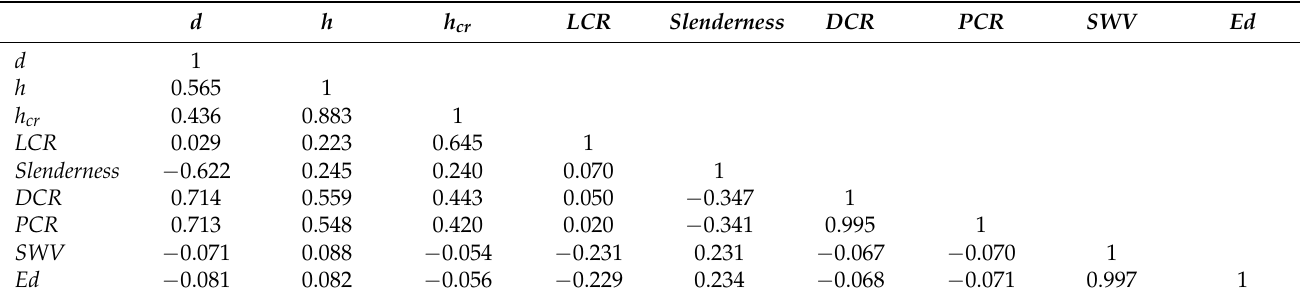
Table 4. Perason’s correlation for regression analysis of dynamic modulus elasticity and tree morphometric parameter ( n =